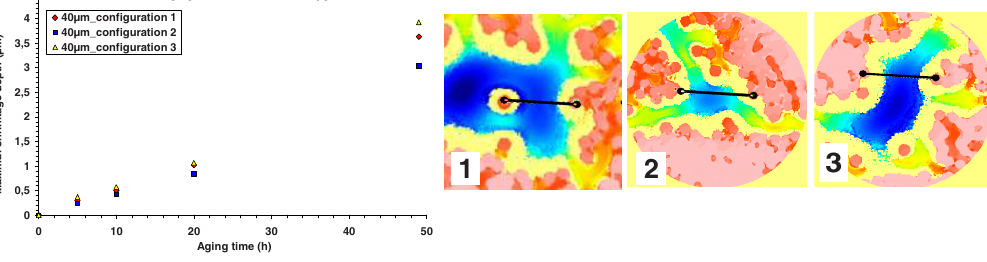
Fig. 7. Evolution of maximal matrix shrinkage depth at sample aged under 1.7 bars oxygen as a function of aging time corresponding to 40µm fibre-to-fibre distance in different fibre configurations